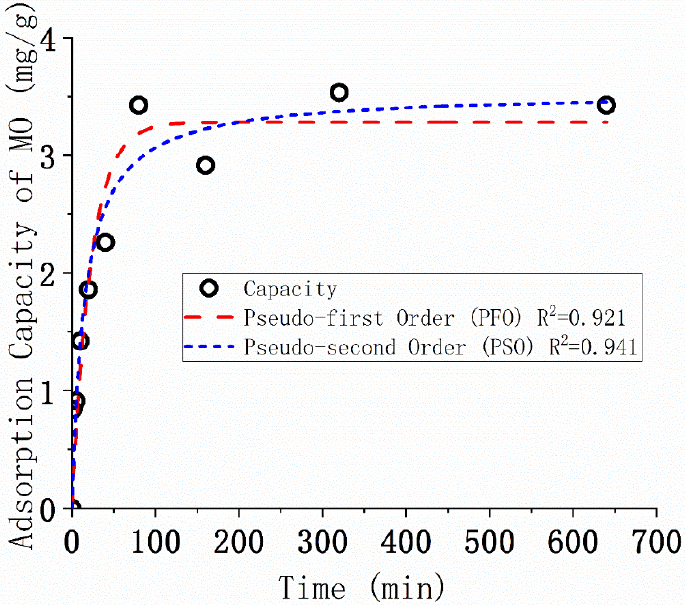
Figure 8. MO adsorption of P-MMt-C400 in different contact time intervals, fitted by pseudo-first- order and pseudo-second-order models.